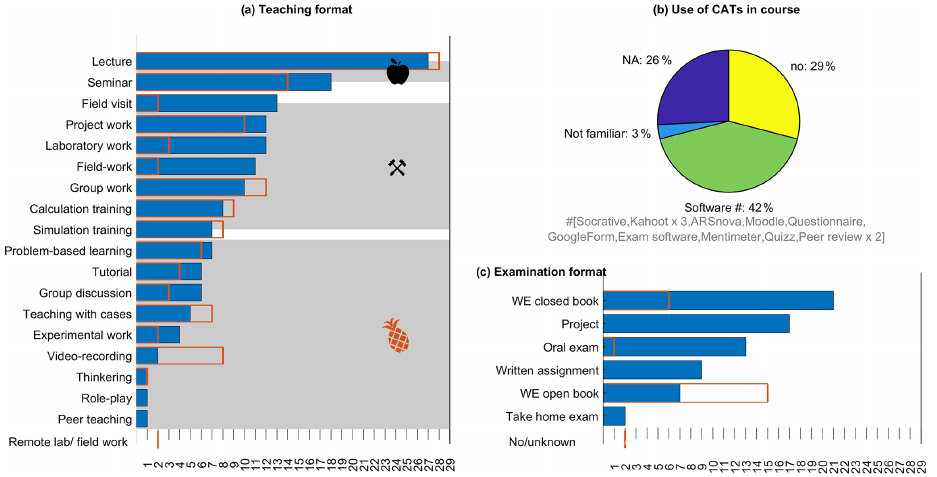
Figure 4. Traditional, practical, and exotic teaching formats indicated as 12, 1, or 12, respectively, used by the respondents before pre- COVID-19 measures (blue bars) and during COVID-19 measures (orange bar), where the x axis indicates the number of respondents (a) . Percentage of respondents who indicated using classroom assessment techniques (CATs), including a specific software application/tool, not answered (NA), not, or not familiar (b) . The respondents indicated using different examination formats before pre-COVID-19 measures (blue bars) and during COVID-19 measures (orange bar), where the x axis indicates the number of respondents (c) .